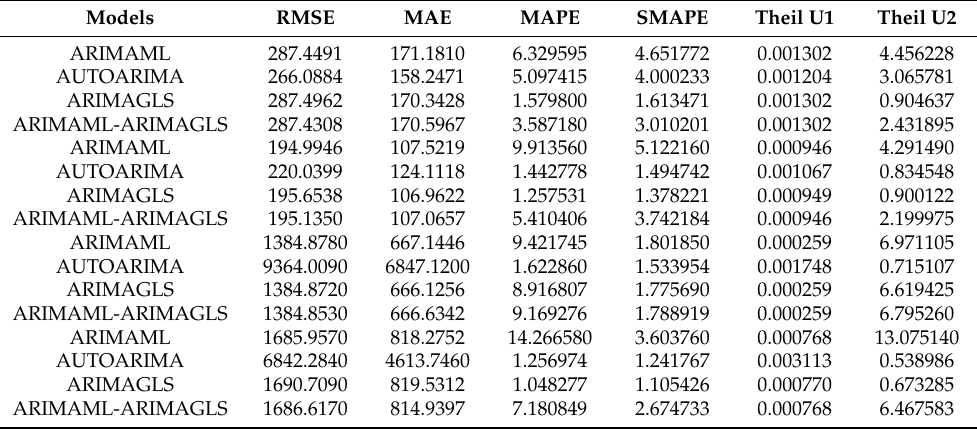
Figure 10. MAPE and RMSE values for: ( a ) LY, ( b ) NG, ( c ) TR, and ( d ) ZA for both training and testing phases. Table 4. Evaluation results for the testing